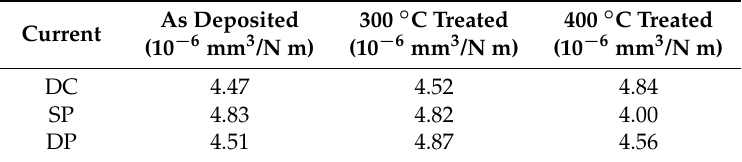
Table 2. Wear rate of Co ‐ P coating samples deposited under different currents (Si 3 N 4 ball as bearing material).